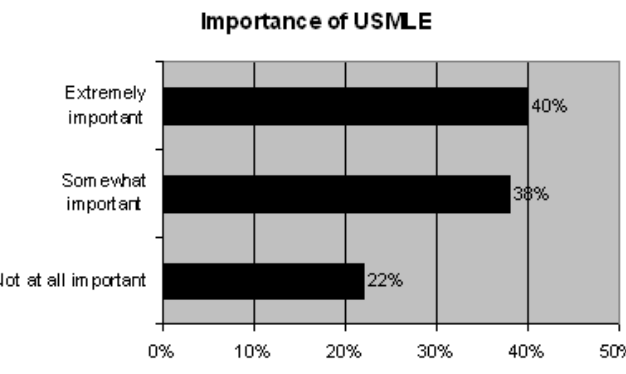
Figure 3. Importance of the United States Medical Licensing Exam.